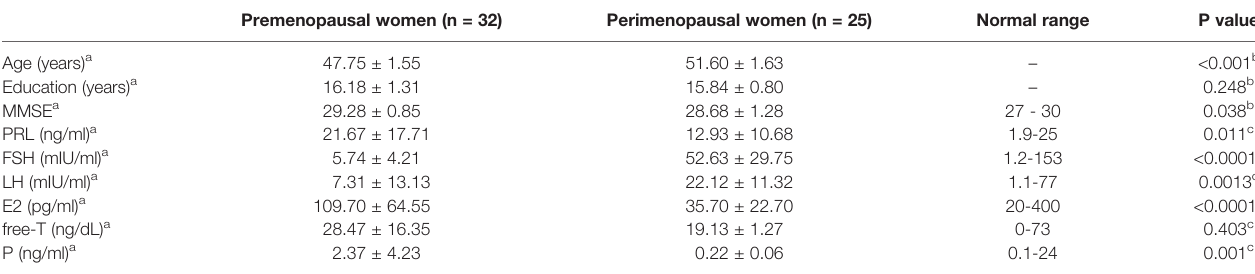
TABLE 1 | Demographic information and sex hormone levels between premenopausal (n = 32) and perimenopausal women (n = 25).